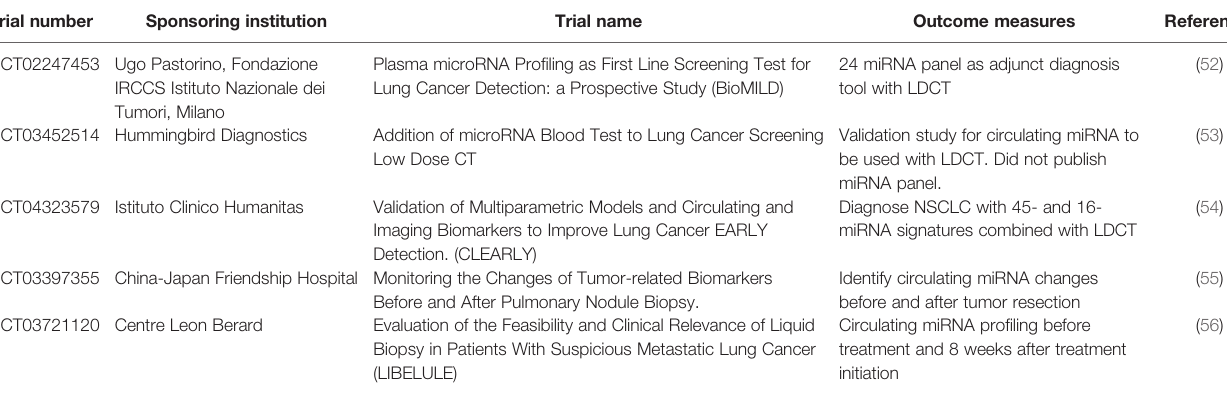
TABLE 2 | Ongoing clinical trials studying using microRNA to detect